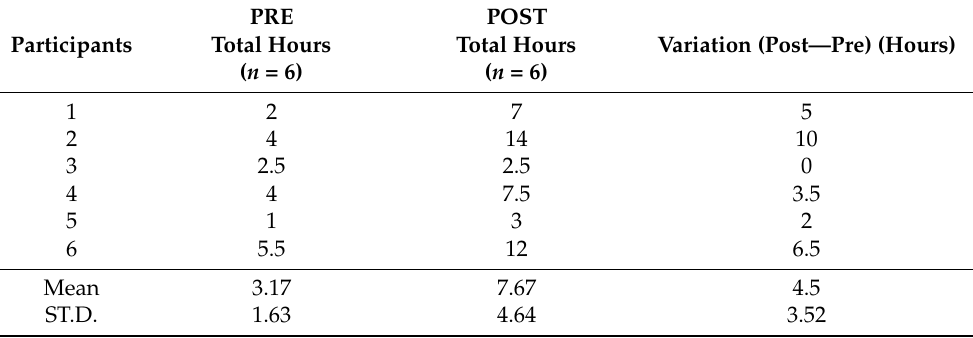
Table 2. Comparison of the number of hours spent on recreational physical activity between the PRE- and POST-bike patrol season.